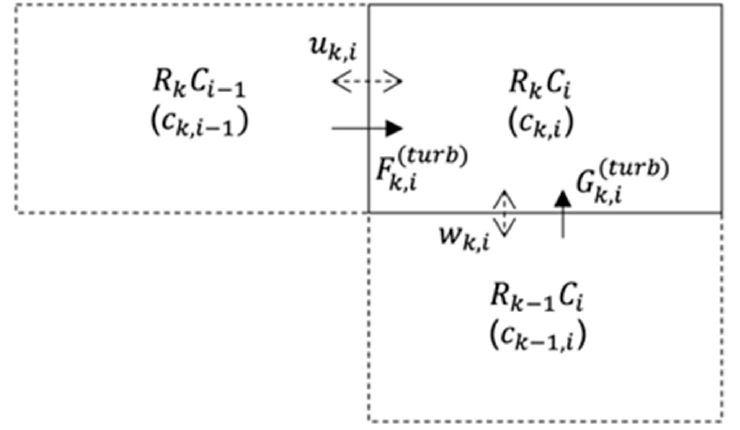
Figure 5. Schematic of the net horizontal and vertical turbulent fluxes of a pollutant into box R k C i , ( turb ) ( turb ) F and G respectively, calculated according to Equations (5) and (6). k , i k , i